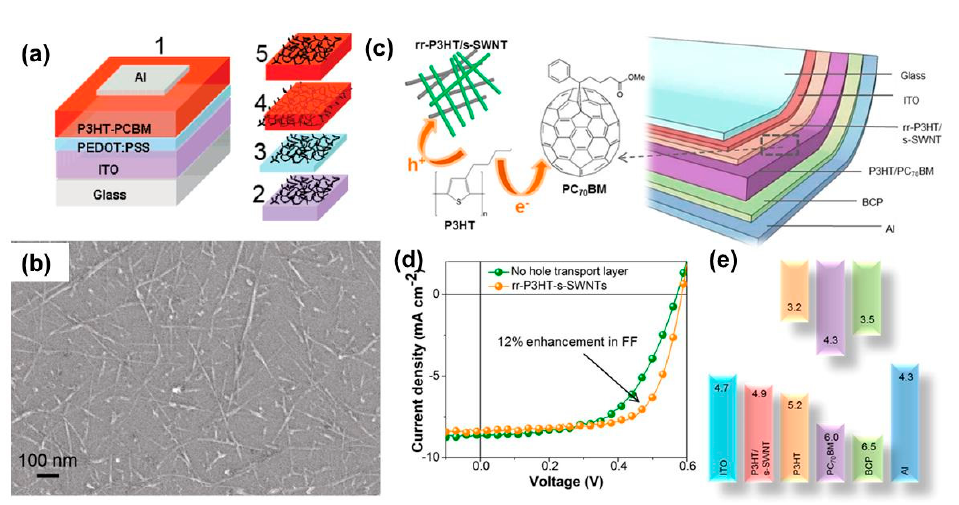
Figure 8. ( a ) Schematic of various devices fabricated for investigation. No. 1 is the control device. Nos. 2–5 represent the layers from the respective devices on which the SWCNT monolayer was dip-coated. For device 4, another active layer was spin-coated after the deposition of the SWNT layer on P3HT/PCBM to effectively embed SWNTs in the P3HT/PCBM phase. ( b ) Monolayer of SWNT dip-coated on an Si substrate from a pristine Dimethylformamide (DMF) suspension. Reproduced with permission [100]. ( c ) Schematic representation of the device architecture used to fabricate solution-processed PSC structures employing rr-P3HT/s-SWNT HTLs. The active layer consists of rr-P3HT/PC70BM, which is sandwiched between rr-P3HT/s-SWNT hole transport and BCP electron transport layers. ITO acts as the anode, whereas Al represents the cathode. ( d ) J–V characteristics of devices A (orange) and B (green) under AM 1.5G illumination with an irradiation intensity of 100 mW cm − 2 . ( e ) Suggested band diagram of the device (ITO / (rr-P3HT / s-SWNT) / (rr-P3HT / PC70BM) / BCP / Al) employing rr-P3HT / s-SWNT nanohybrids as an electron-blocking layer. The energy values are in electron volts. Reproduced with permission [101] .